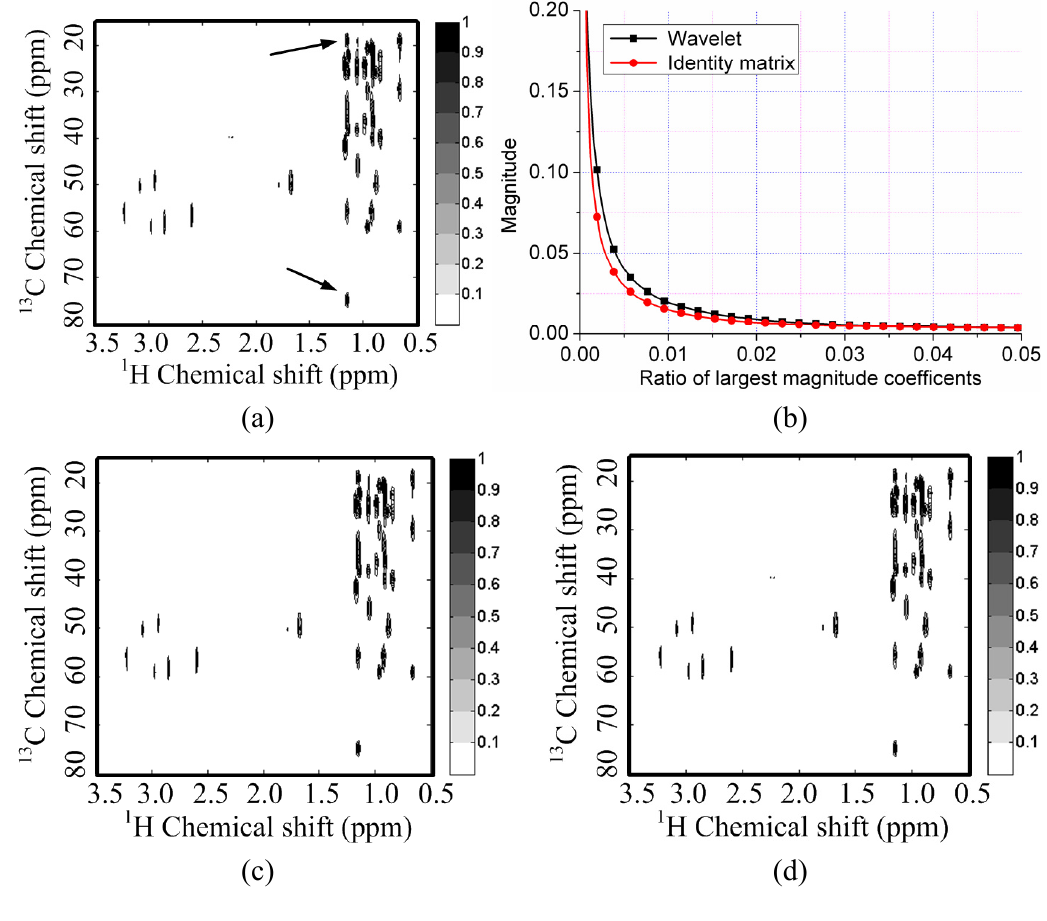
Figure 5. Sparsity of a 1 H- 13 C COSY spectrum and its wavelet (symmlet